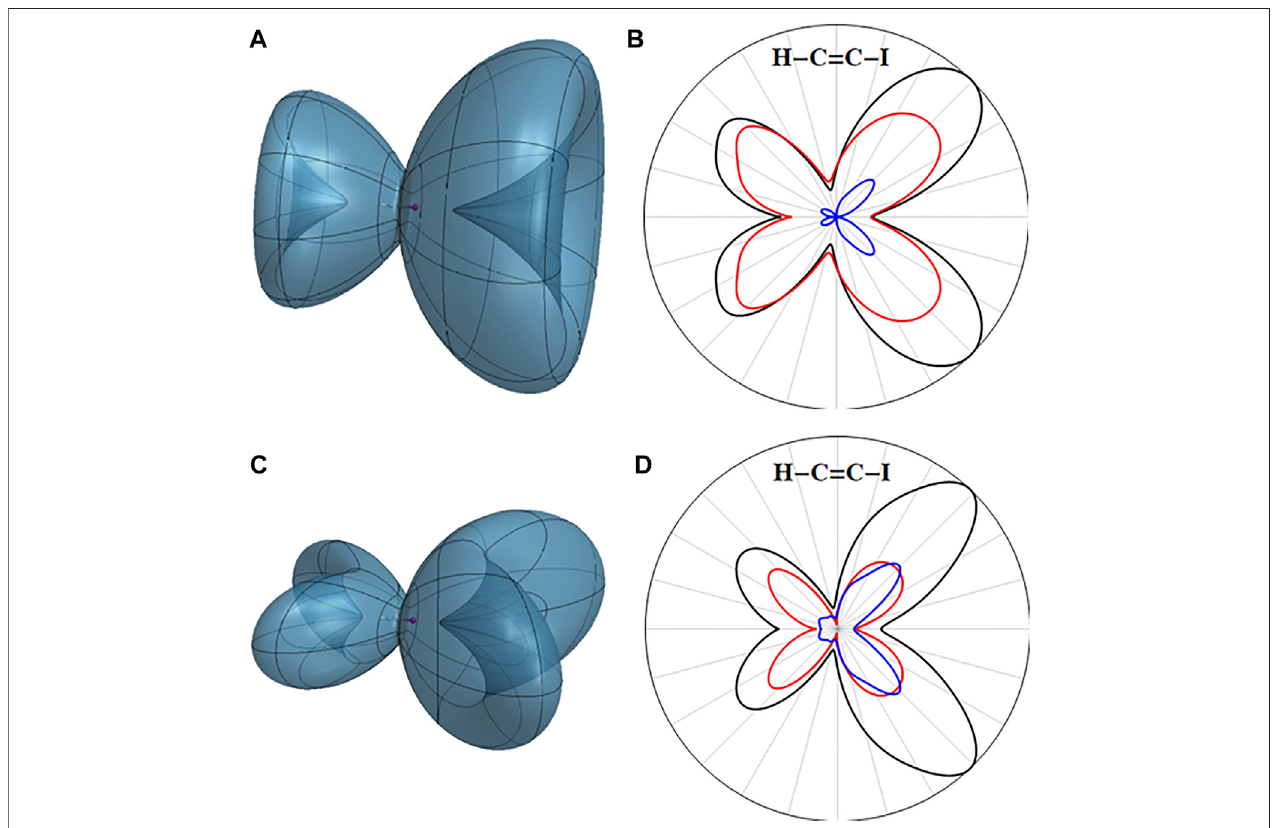
FIGURE3| Three-dimensionalangulardependenceoftheinstantaneousionizationrateforthegroundstateoftheHCCIcationinastatic fi eldof0.055aufor (A) the X ( (cid:2) π p − 1 + )cation and (C) theX( (cid:2) π p − 1 x )cation. Totalionizationratesinthexzplaneinblackandcontributionsfromionizingthe π p orbitalsinredand fromthe π orbitalsinblue for (B) the X ( (cid:2) π p − 1 + ) cation and (D) the X ( (cid:2) π p − 1 x )